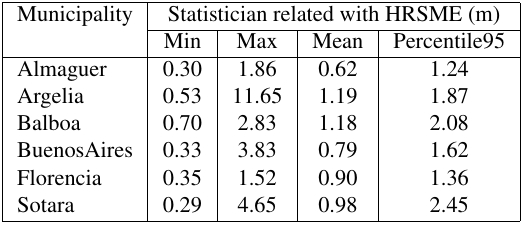
Table 4: Horizontal Root Mean Square Error parameter With the exception of the municipality Argelia 100% of the land- marks placed in the field satisfied the maximum tolerance of 5 m port of Colombia. In the municipality of Argelia, although there were only two values greater than 5.0 m accuracy, 99.3% of them were smaller than 5.0 m accuracy.